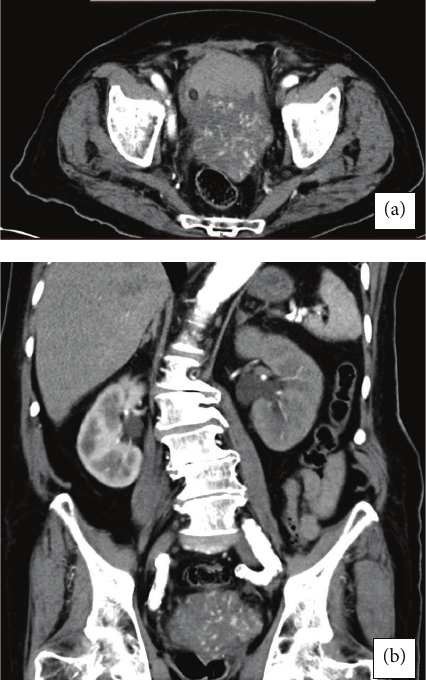
Figure 1: Computed tomography of our patient. (a) Highly vascular mass originating from the left bladder wall, but a prostatic origin could not be absolutely rolled out by CT. (b) Hydronephrosis on the left side and coronal view of the mass.